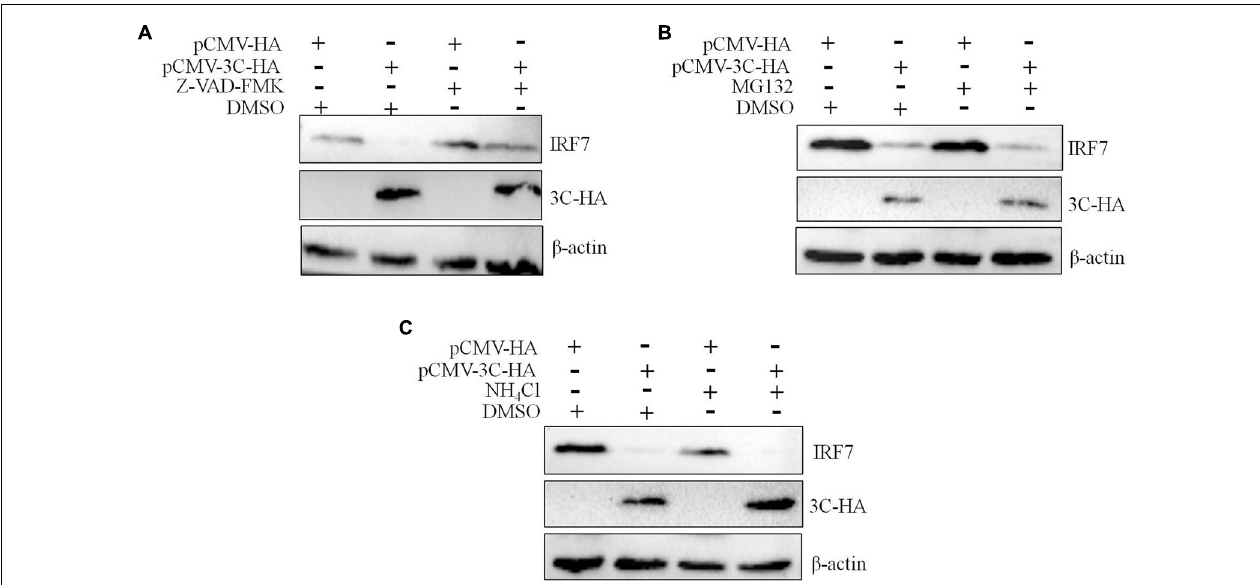
FIGURE 7 | The degradation of IRF7 induced by the 3C protein is caspase-dependent. A total of 1.6 µ g of pCMV-3C-HA and 1.6 µ g of pCMV-HA were transfected into DEFs. Twenty-four hours after transfection, the broad-spectrum caspase inhibitor Z-VAD-FMA (50 µ M), proteasome inhibitor MG132 (20 µ M), autophagy inhibitor 3-MA (10 mM), and autophagosome-lysosome inhibitor NH 4 Cl (10 mM) were added to the cell culture medium, with a DMSO negative control group set up at the same time. After 12 h of treatment, cell samples were collected and subjected to immunoblotting experiments to detect the endogenous IRF7 expression level in the presence or absence of the inhibitors. (A) The effect of Z-VAD-FMK on IRF7 protein degradation. (B) The effect of MG132 on IRF7 protein degradation. (C) The effect of NH 4 Cl on IRF7 protein degradation.